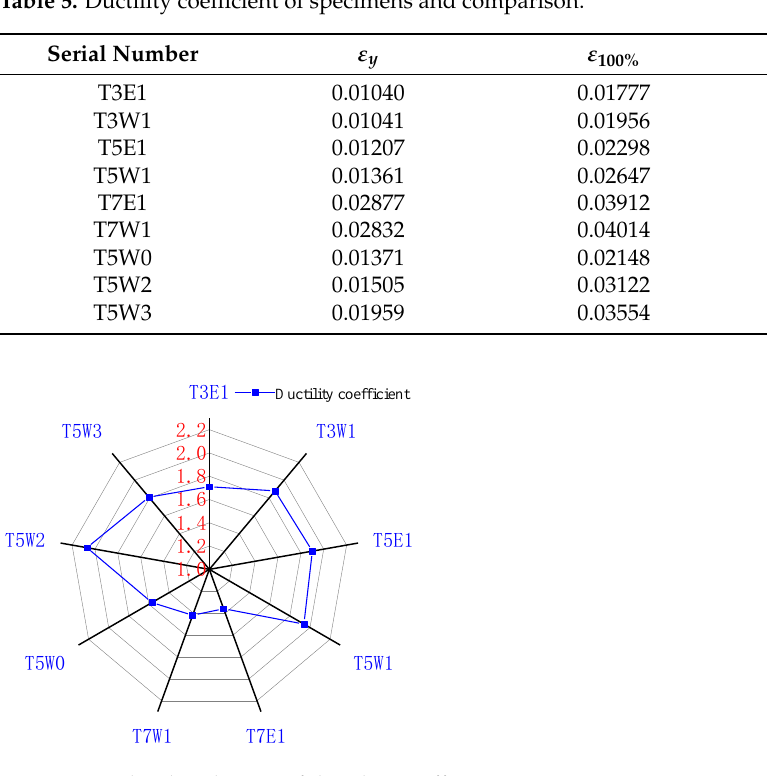
Figure 6. Radar distribution of ductility coefficient.